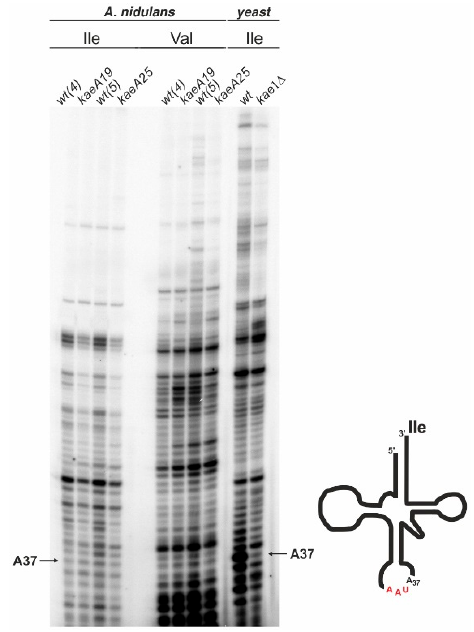
Figure 1. Primer extension analysis of tRNA Ile and tRNA Val in A. nidulans and S. cerevisiae. A fraction of small RNAs was isolated from kaeA19 , kaeA25 , kae1 ∆ mutant, and respective control strains. The of small RNAs was isolated from kaeA19 , kaeA25 , kae1 Δ mutant, and respective control strains. The position of the modified t6A 37 nucleotide is position of the modified t6A 37 nucleotide is indicated.